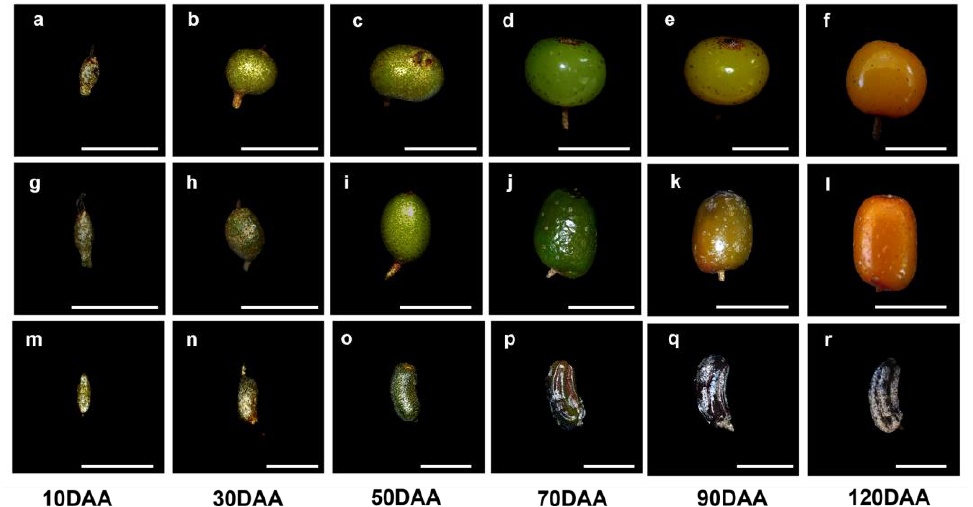
Figure 1. Morphological phenotypes of fruits of three species of Hippophae from full fruitlets at 10 DAA until the maturation (120 DAA). ( a – f ) H. rhamnoides ssp. sinensis ; ( g – l ) H. goniocarpa ; ( m – r ) H. neurocarpa ; Bars = 5 mm.